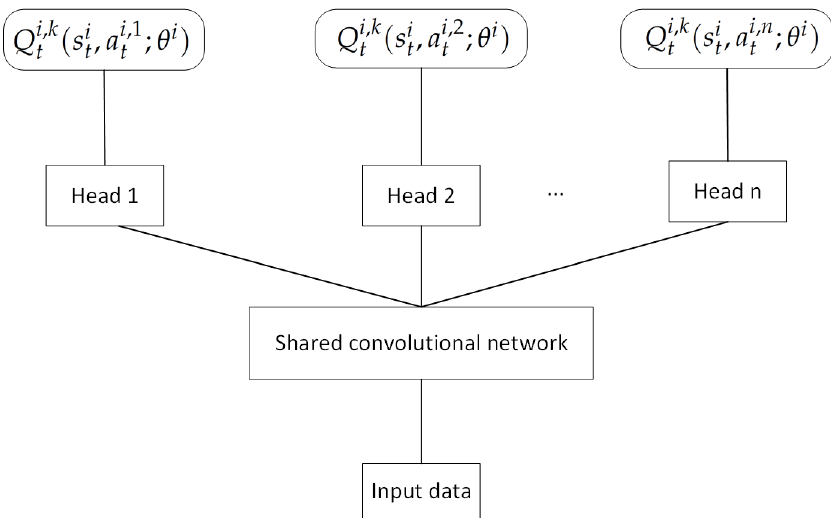
Figure 7. Architecture of the bootstrapped MADQN